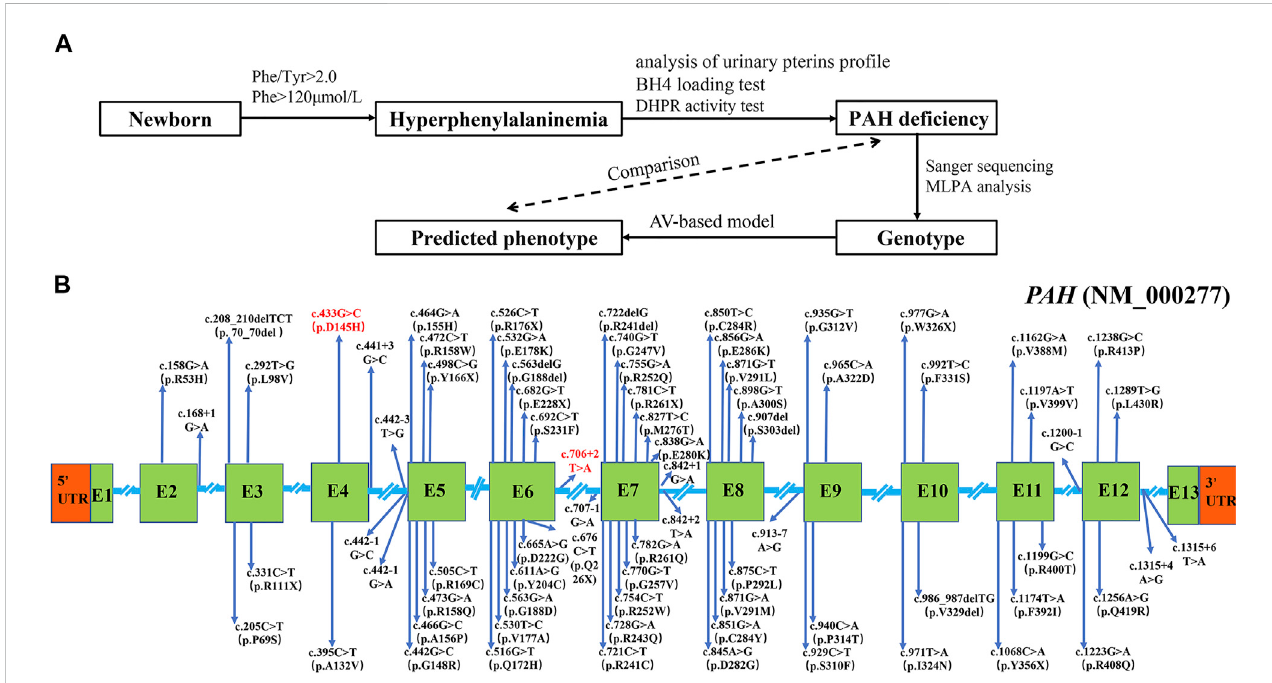
FIGURE 1 Mutation analysisof123PAHDpatients. (A) Work fl owofPAHDpatient ’ senrollmentandfollow-uptestinginthestudy. (B) Thedisease-causing mutations were identi fi ed by Sanger sequencing in Jiangxi province. Novel mutations were marked red. Abbreviations: E, exon.